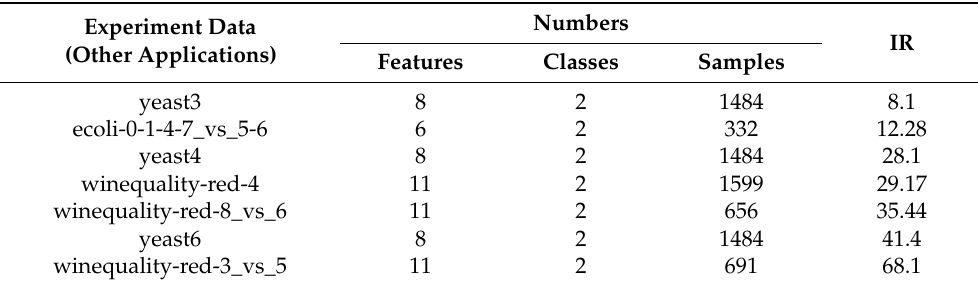
Table 4. Information of other imbalanced data sets.